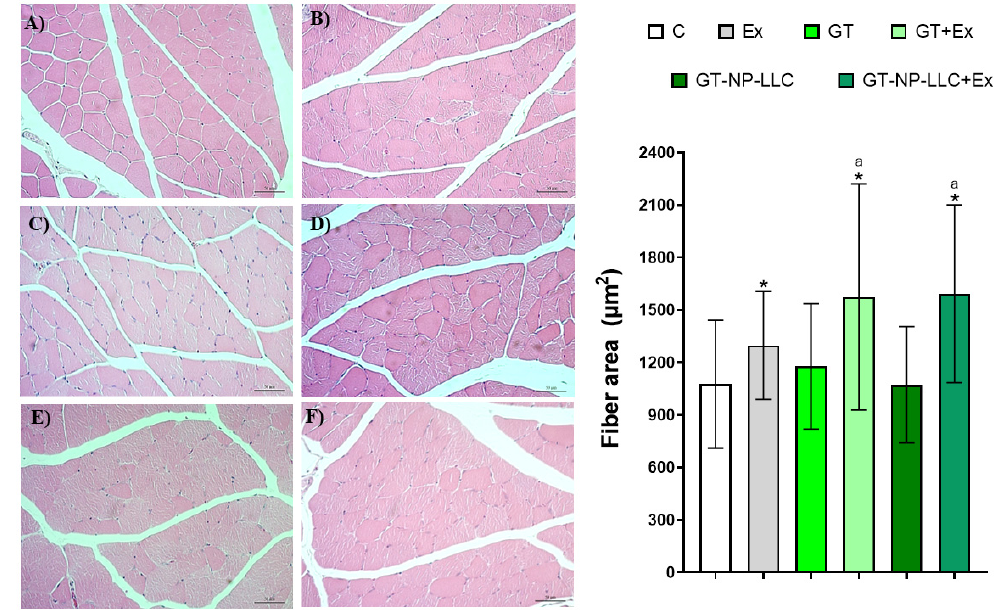
Figure 4. Gastrocnemius histological slices and fiber muscle size of the muscle area: ( A ) Control; ( B ) Green tea (GT); ( C ) GT loaded in nanoparticles of lyotropic liquid crystal (NP-LLC); ( D ) Exercise (Ex); ( E ) GT+Ex; ( F ) GT loaded in NP-LLC+Ex. Note: Mean ± SD * p < 0.05 compared to C, GT and NP-LLC, a p < 0.05 compared to Ex.